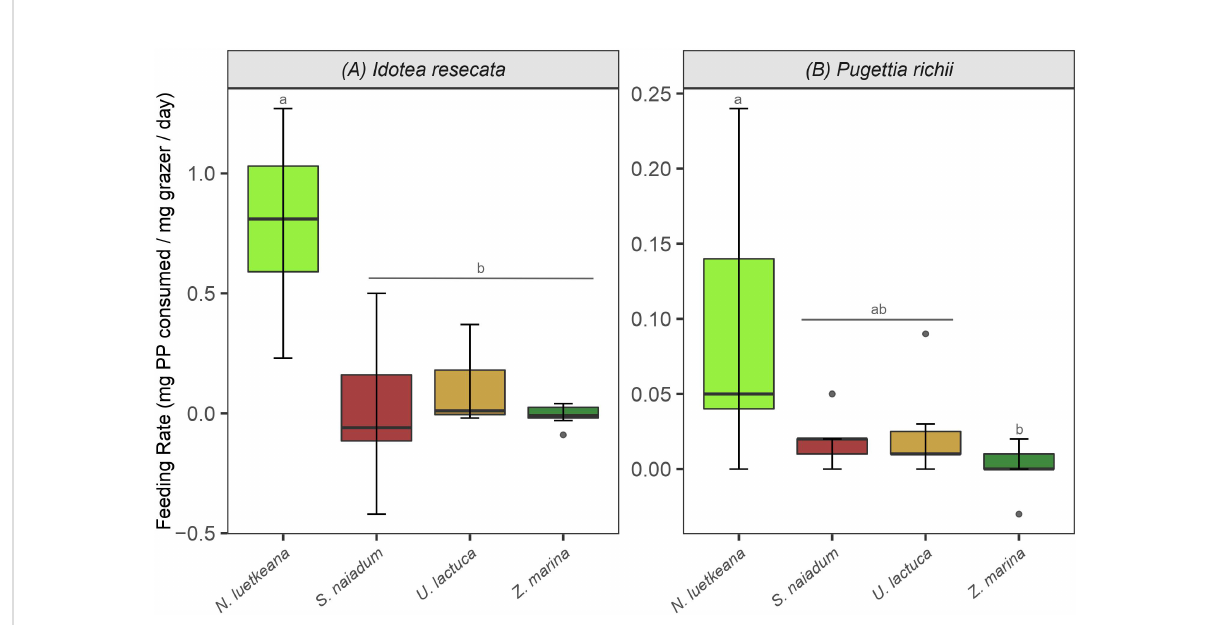
FIGURE 2 Consumption rates (mean and standard error) by (A) I. resecata isopods and (B) P. richii crabs on macrophytes from the feeding trials - N . luetkeana , S. naiadum , U. lactuca and Z. marina . Note the differing scales for each mesograzer. Letters indicate treatments that are signi fi cantly different from one another. The fi gure represents the full and raw dataset, and negative values derived from the consumption equation were retained for